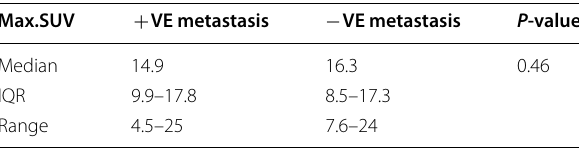
SD standard deviation, IQR =